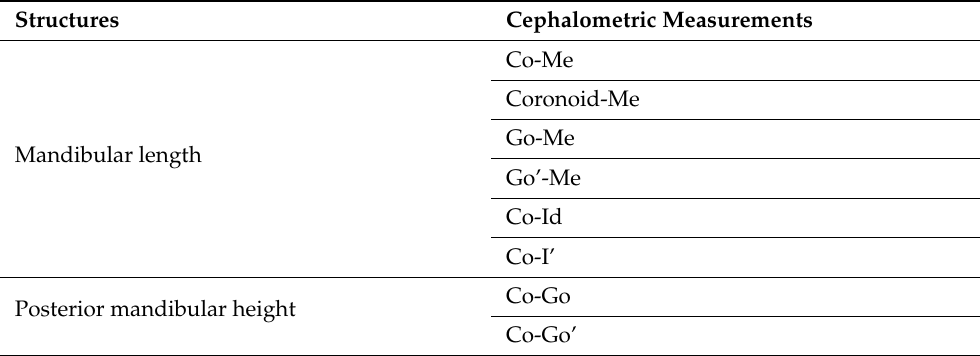
Table 2. Linear cephalometric measurements corresponding to mandibular length and height.